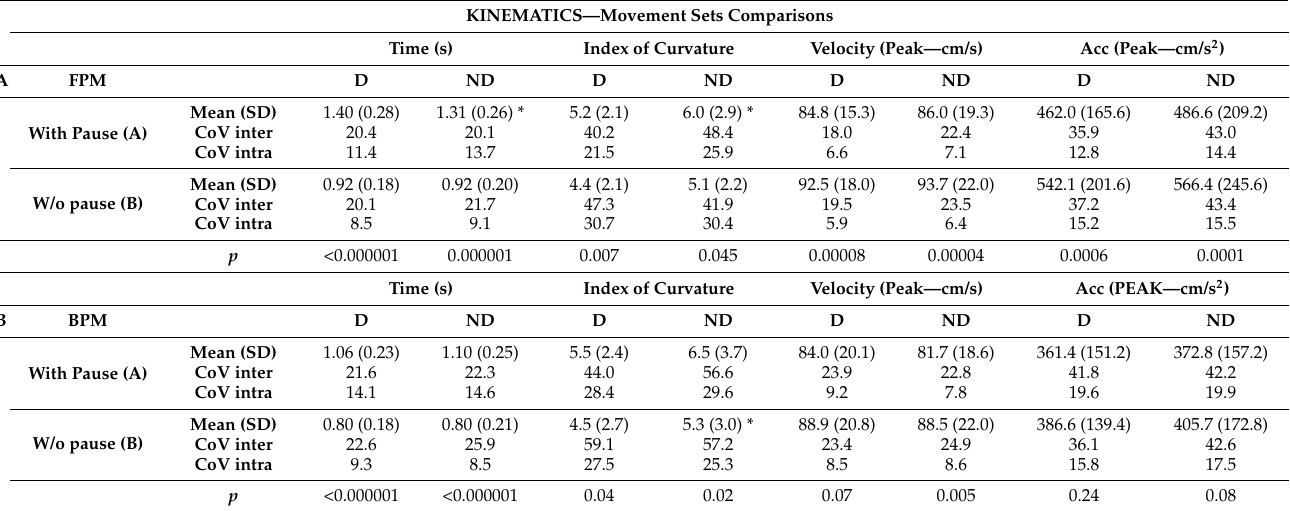
Table 1. Movement set comparisons for a given